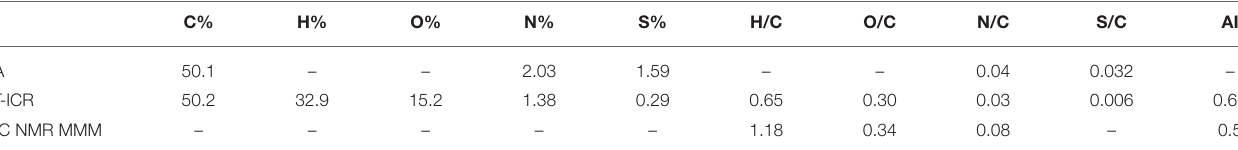
TABLE 4 | Elemental composition of Idaho HA as determined by elemental analysis (EA), FT-ICR ESI MS, 13 C CPMAS NMR (through molecular mixing model MMM).